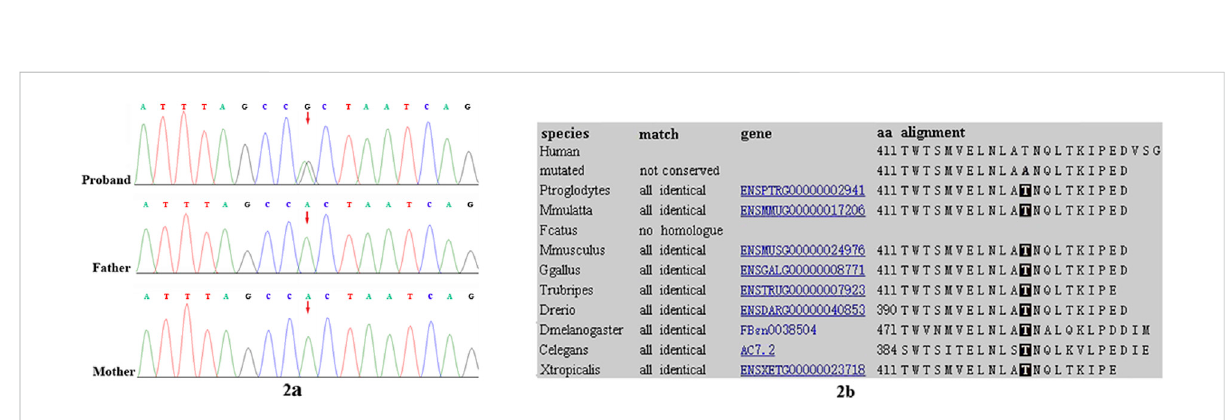
FIGURE 2 Sangersequencingresults for(A) ourpatient, andthepatient ’ s(B)mother and(C) father.The analysis demonstrated thepresence of amissense SHOC2 variant (c.1231A > G, p.Thr411Ala; red arrow) in our patient and the absence of the variant in her parents (2A) . Location of patient ’ s